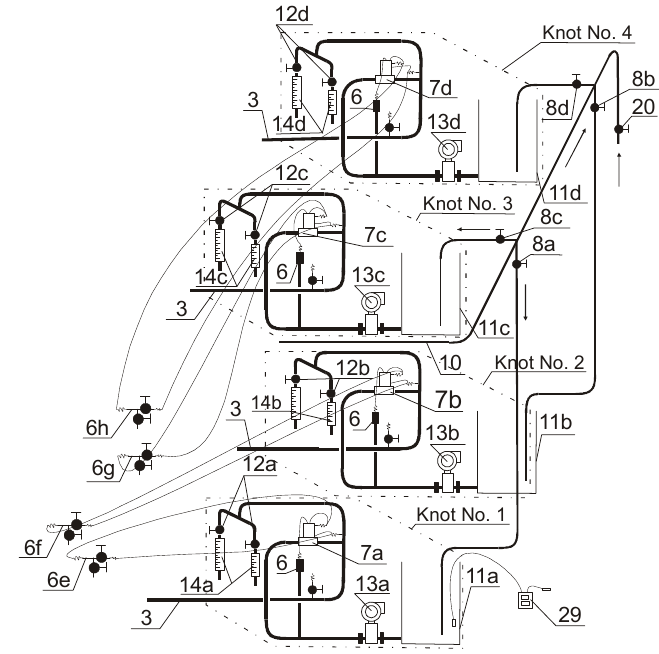
Figure 3. Emptying knots acc. Figure 2: 3-vacuum pipeline with diameter of 57 mm; 6-sensor pipe; 6e,f,g,h-cutoff valve; 7a,b,c,d-interface valve; 8a,b,c,d-control valve; 10-pressure pipeline; 11a,b,c,d-collector well; 12a,b,c,d-air control valve; 13a,b,c,d-electronic liquid flow meter; 14a,b,c,d-rotameter; 20-liquid supplying system cut-off valve; 29-electronic